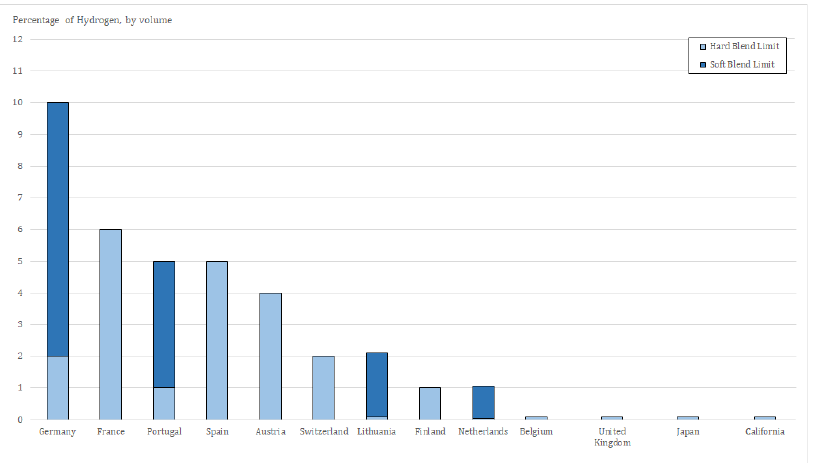
Figure 6. Current limits on hydrogen blending in natural gas networks for selected locations. Adapted from [47]. Note: The soft blending limits shown reflect the following conditional parame- ters: (1) Germany, if there are no compressed natural gas filling stations connected to the